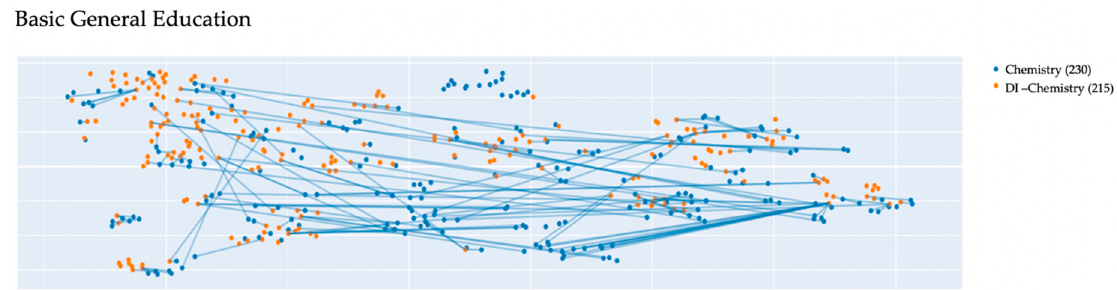
Figure 6. Semantic correlations between the didactic item titles in the topical framework and the lesson script titles in the subject Chemistry. Table 3. Example of data mapping representation for expert